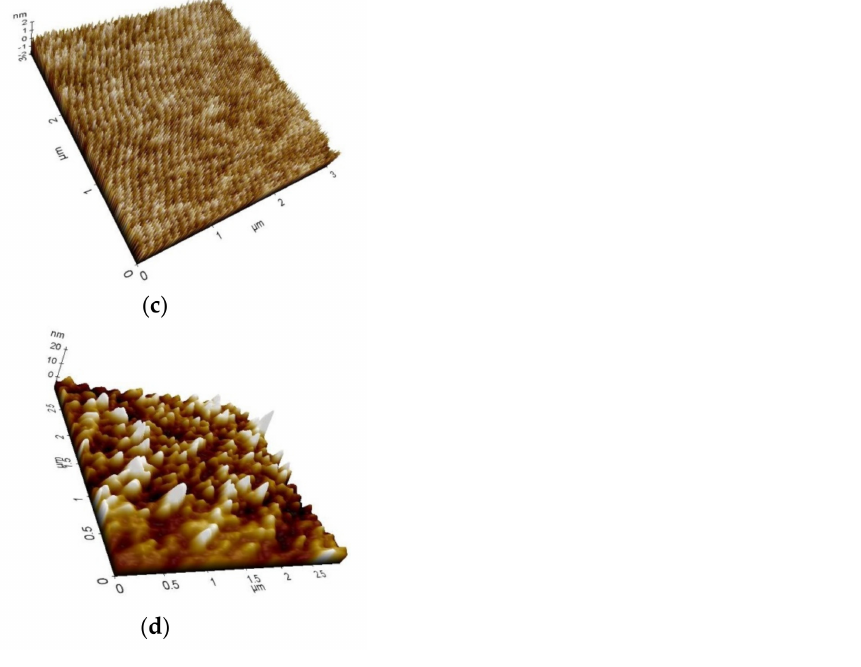
Figure 25. AFM-3D surface images of thin films samples. ( a ) TiO 2 /Si; ( b ) TiN/Si; ( c ) NbN/Si; ( d ) Au/Cr/SiO 2 /Si.